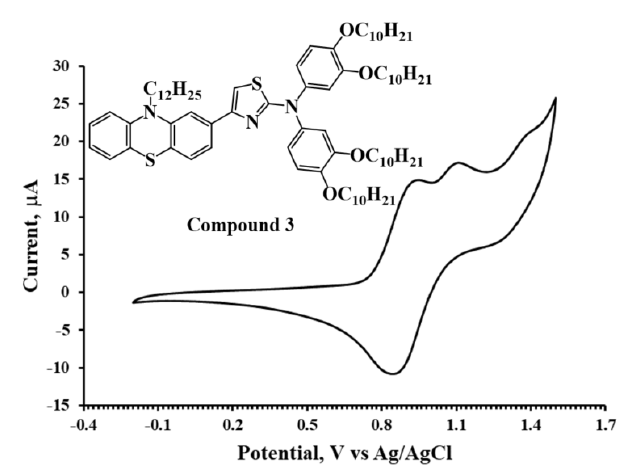
Figure 3. Cyclic voltammogram of Compound 2 in DCM solution (10 − 3 M).